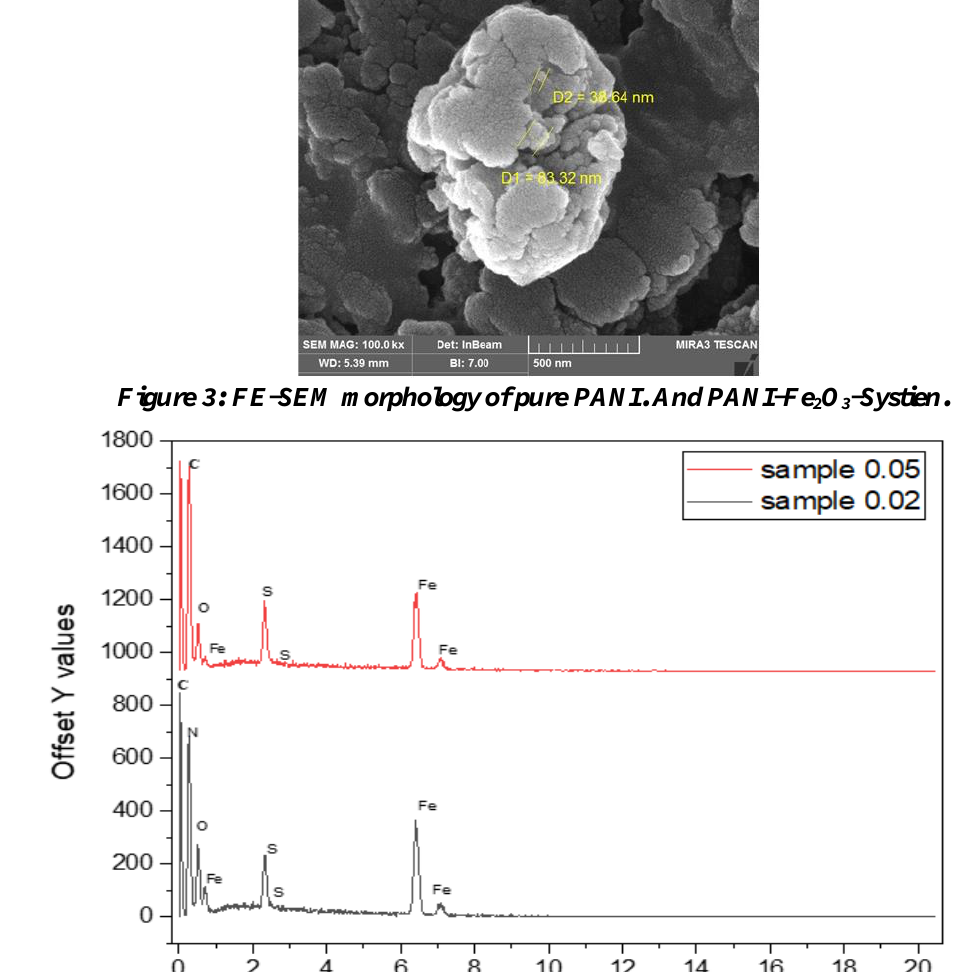
Figure 4: EDX analysis for Polyaniline with iron II dioxide-Cyst